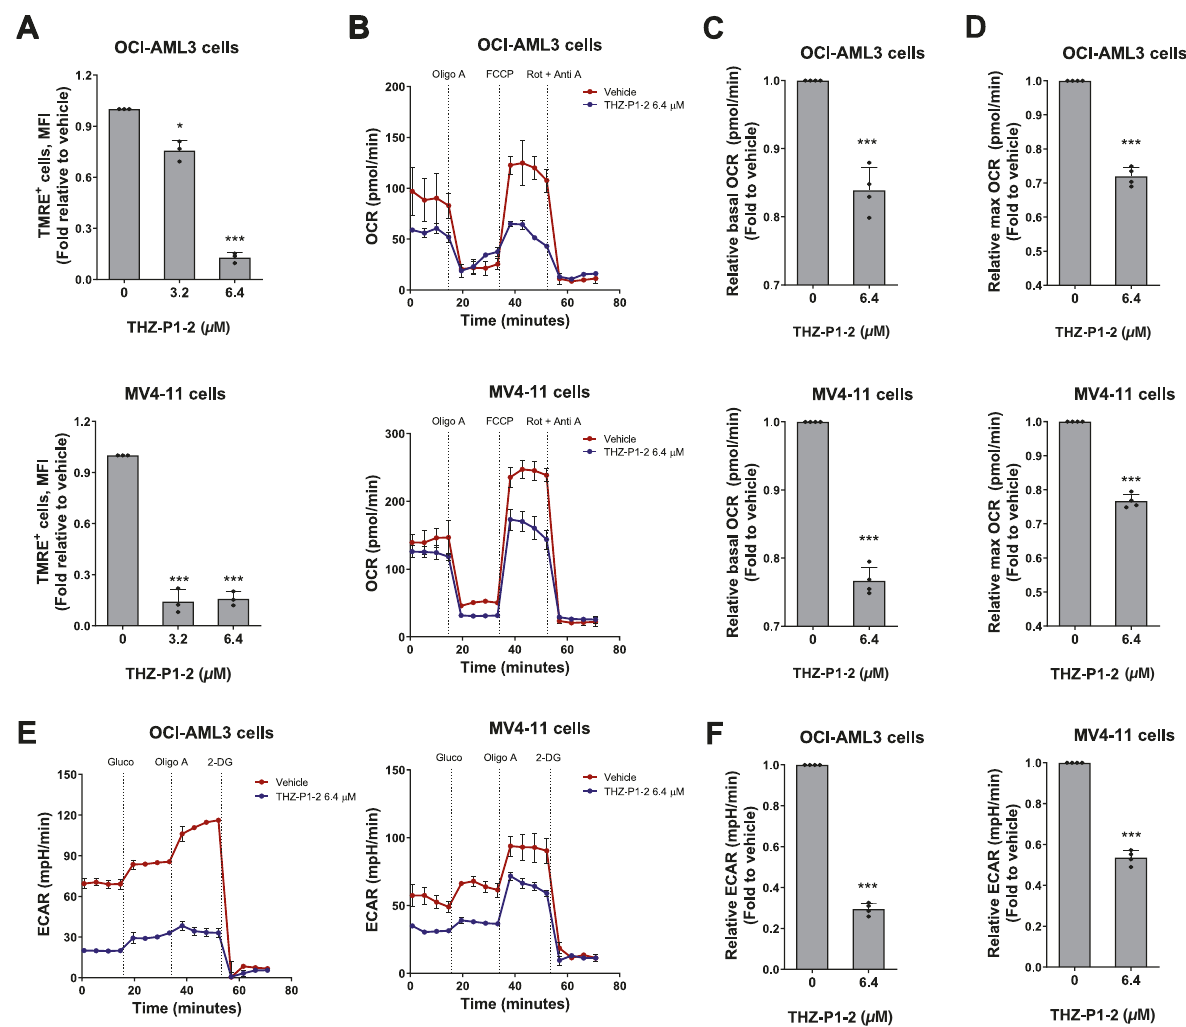
Fig. 4 THZ-P1-2 reduces cellular metabolism in leukemic cells. A Mitochondrial membrane potential analysis was evaluated using the tetramethylrhodamine, ethyl ester, perchlorate (TMRE) staining method and fl ow cytometry. OCI-AML3 and MV4-11 cells were treated with vehicle or THZ-P1-2 (3.2, and 6.4 μ M) for 24h. Values are expressed as the fold-change of vehicle-treated cells. Bar graphs represent the mean ±SD of at least three independent experiments and the p values are indicated; * p <0.05, *** p <0.0001; ANOVA and Bonferroni post-test. B Oxygen consumption rate (OCR) was determined in vehicle- or THZ-P1-2-treated (6.4 μ M) OCI-AML3 and MV4-11 cells using a high-resolution respirometry. A representative line graph containing OCR upon sequential addition of oligomycin (Oligo A), carbonyl cyanide-p- tri fl uoromethoxyphenylhydrazone (FCCP), and rotenone plus antimycin (Rot + Anti A) are illustrated; OCR was measured over time. Values are expressed as the fold-change of vehicle-treated cells. Bar graphs represent the mean ±SD of OCR at baseline ( C ) and maximum state (upon FCCP) ( D ) of at least three independent experiments. The p values and cell lines are indicated in the graphs; *** p <0.0001; Student t -test. E Extracellular acidi fi cation rate (ECAR) was evaluated in vehicle- or THZ-P1-2-treated (6.4 μ M) OCI-AML3 and MV4-11 cells by Seahorse XF96 analyzer. A representative line graph containing ECAR upon sequential addition of glucose (Gluco), oligomycin (Oligo A), and 2-deoxy- D -glucose (2-DG) is illustrated; ECAR was measured over time. F Values are expressed as the fold-change of vehicle-treated cells. Bar graphs represent the mean ±SD of at least three independent experiments. The p values and cell lines are indicated in the graphs; *** p <0.0001; Student t